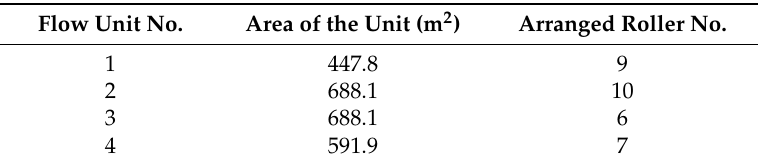
Table 1. Basic information about the four simulated flow units. Flow Unit No. Area of the Unit (m 2 ) Arranged Roller